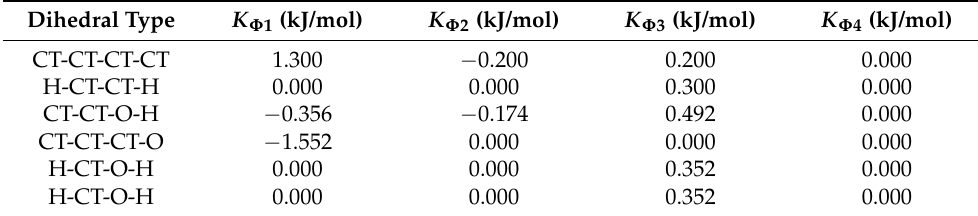
Table 4. Torsion of dihedral for